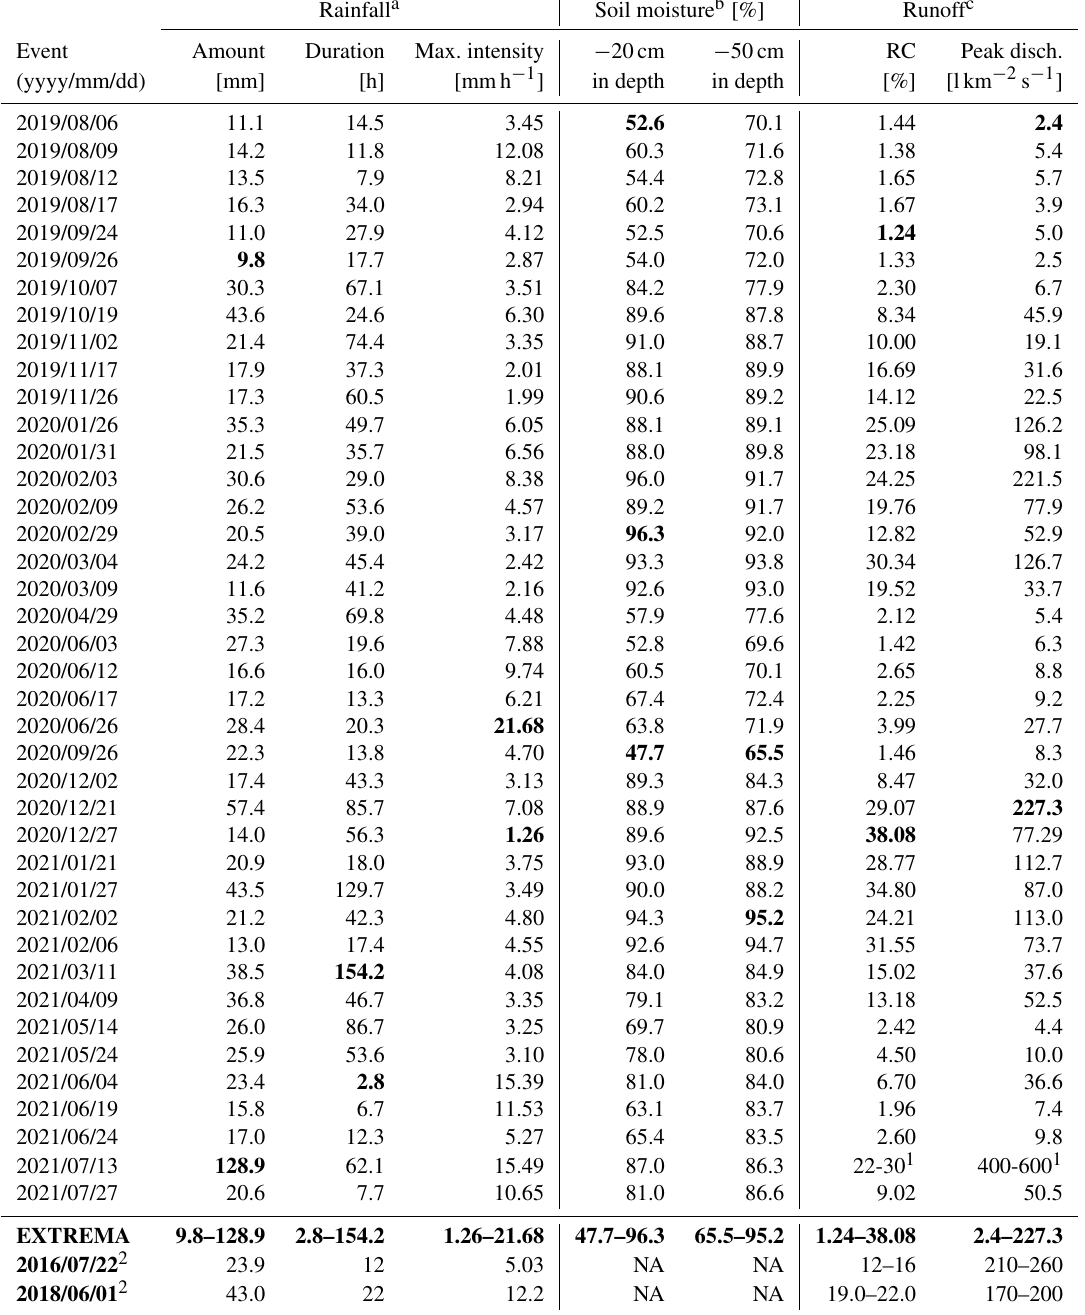
Table 2. Rainfall event properties, initial soil moisture and discharge characteristics. a rainfall statistics relate to the Medernach upper catchment. b initial soil moisture values correspond to the arithmetic mean of the four observed TS. c RC: runoff coefficient calculated for the Medernach upper catchment; peak discharge: arithmetic mean of peak discharge observed at Koedange and Medernach. In bold: extreme values. (1) The peak discharge and the runoff coefficient was roughly estimated for the 13 July 2021 event. (2) The 2016 and 2018 flash flood events properties were assessed for the Ernz Blanche catchment at Larochette. NA – not